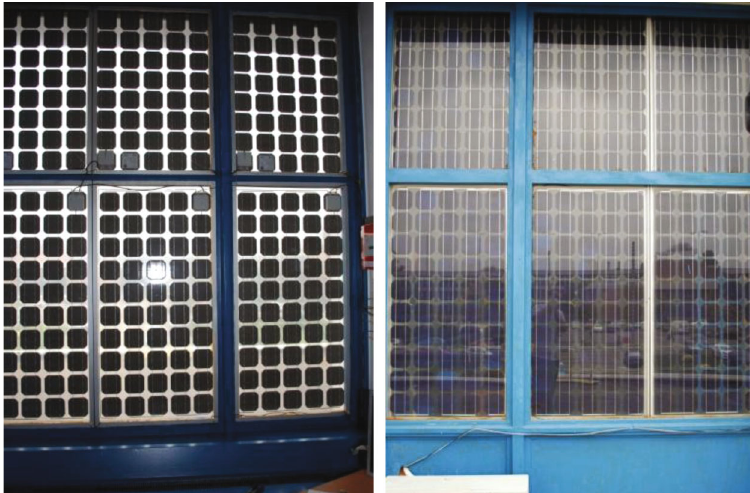
Figure 3: BIPV system developed within the laboratory of nanostructures, solar cells, and PV systems from the Department of Physics, Faculty of Applied Sciences, Polytechnic University of Bucharest (inside/outside view).